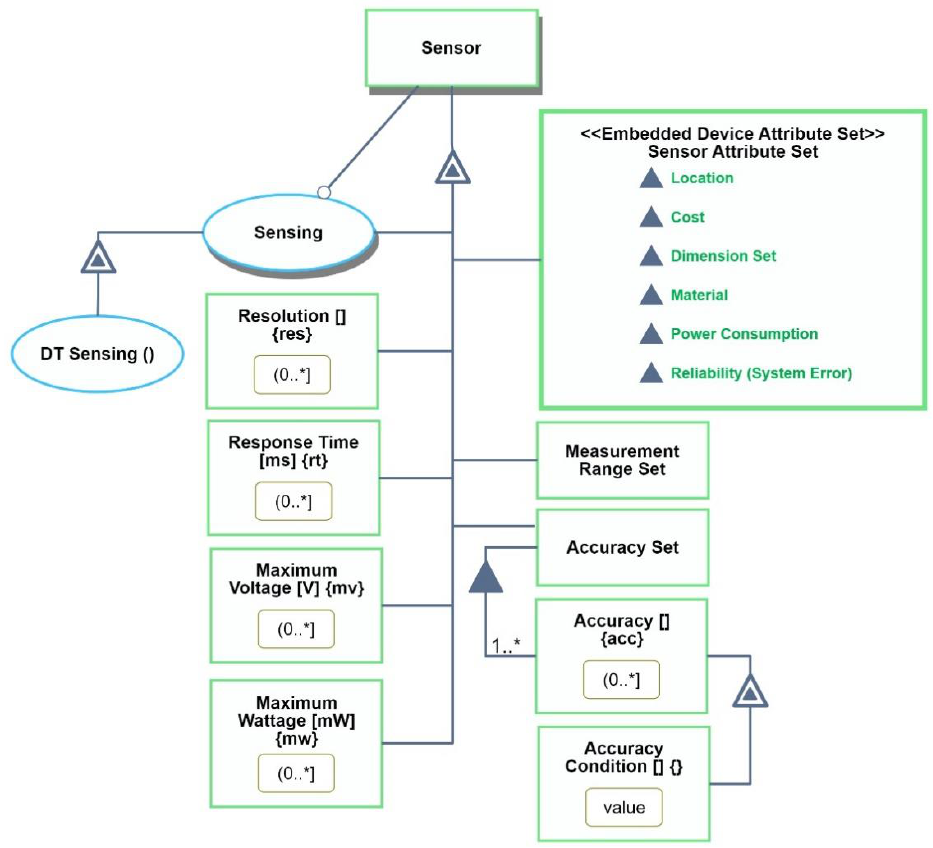
Figure 14. The Sensor stereotype.